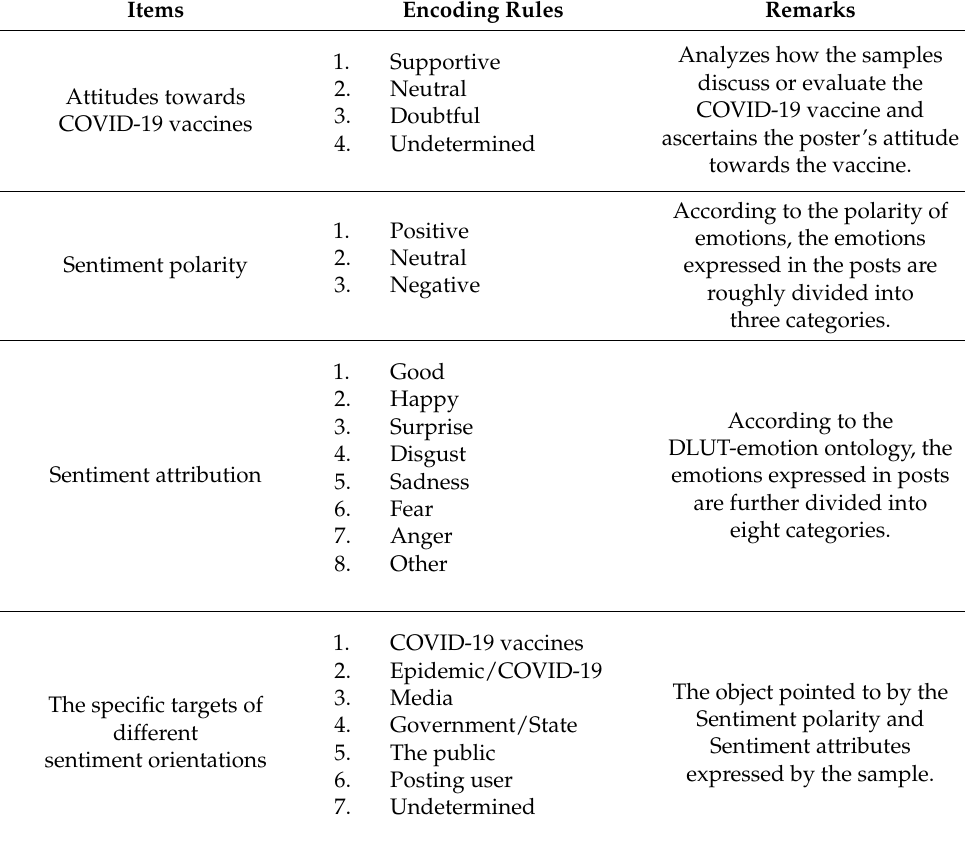
Table 2. Content analysis coding